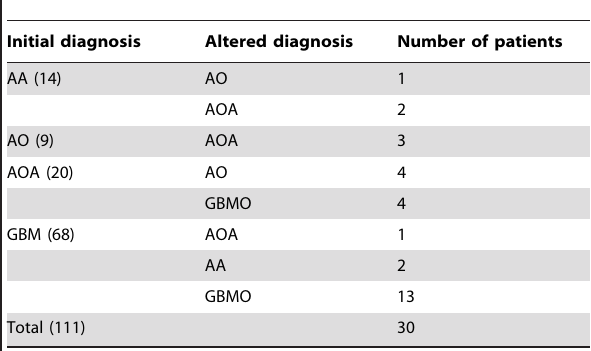
Table 1. Characteristics of 111 Patients. Table 2. Summary of the cases of altered diagnosis.